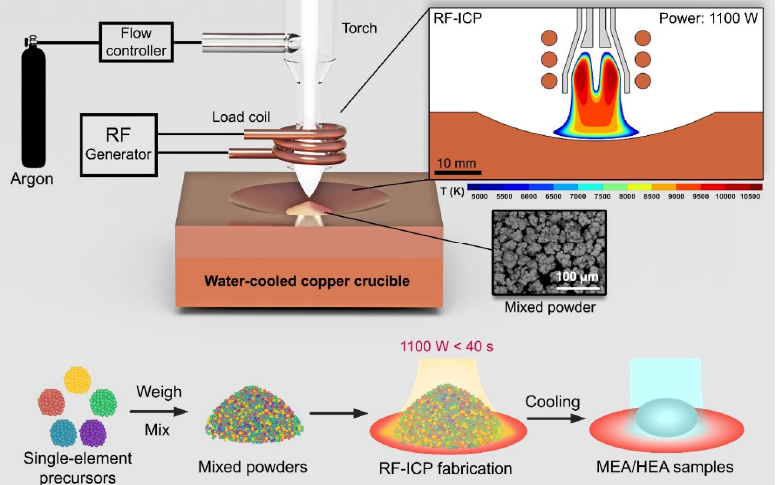
Figure 4. Setup of HEA synthesis with RF-ICP. Well-mixed powder bed is directly synthesized by RF-ICP under 1100 W with 5000–8000 K and becomes HEAs within 40 s [17].